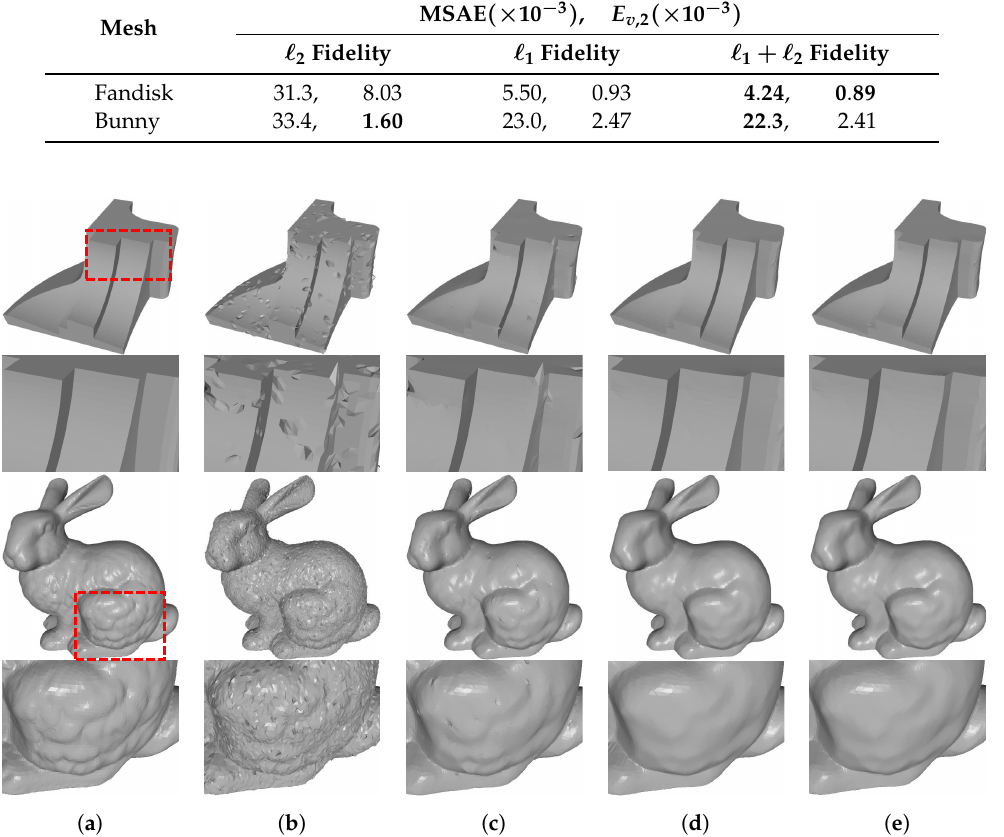
Figure 11. (cid:96) 1 + (cid:96) 2 fidelity vs. (cid:96) 2 and (cid:96) 1 fidelities. From left to right: ( a ) clean meshes; ( b ) noisy meshes, denoising results produced by ( c ) (cid:96) 2 fidelity; ( d ) (cid:96) 1 fidelity; and ( e ) (cid:96) 1 + (cid:96) 2 fidelity. Fandisk in the first row is corrupted with 10% of impulsive noise with scale of 0.7 mean edge length, while Bunny in the third row is corrupted with 10% of impulsive noise with 0.6 edge length and Gaussian noise with standard deviation σ = 0.15 mean edge length. The even rows are zoomed-in